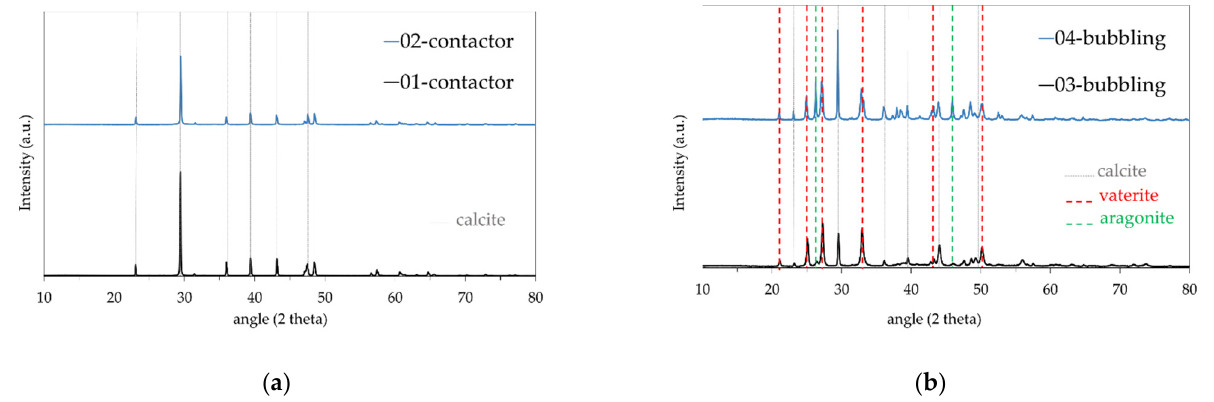
Figure 4. XRD analysis results for samples produced in ( a ) contactor mode; ( b ) bubbling mode. The calcite crystallite size, shown in Table 3, was calculated by applying the Debye- Scherrer formula on the Full Width at Half Maximum (FWHM) of the main peak at 29.42